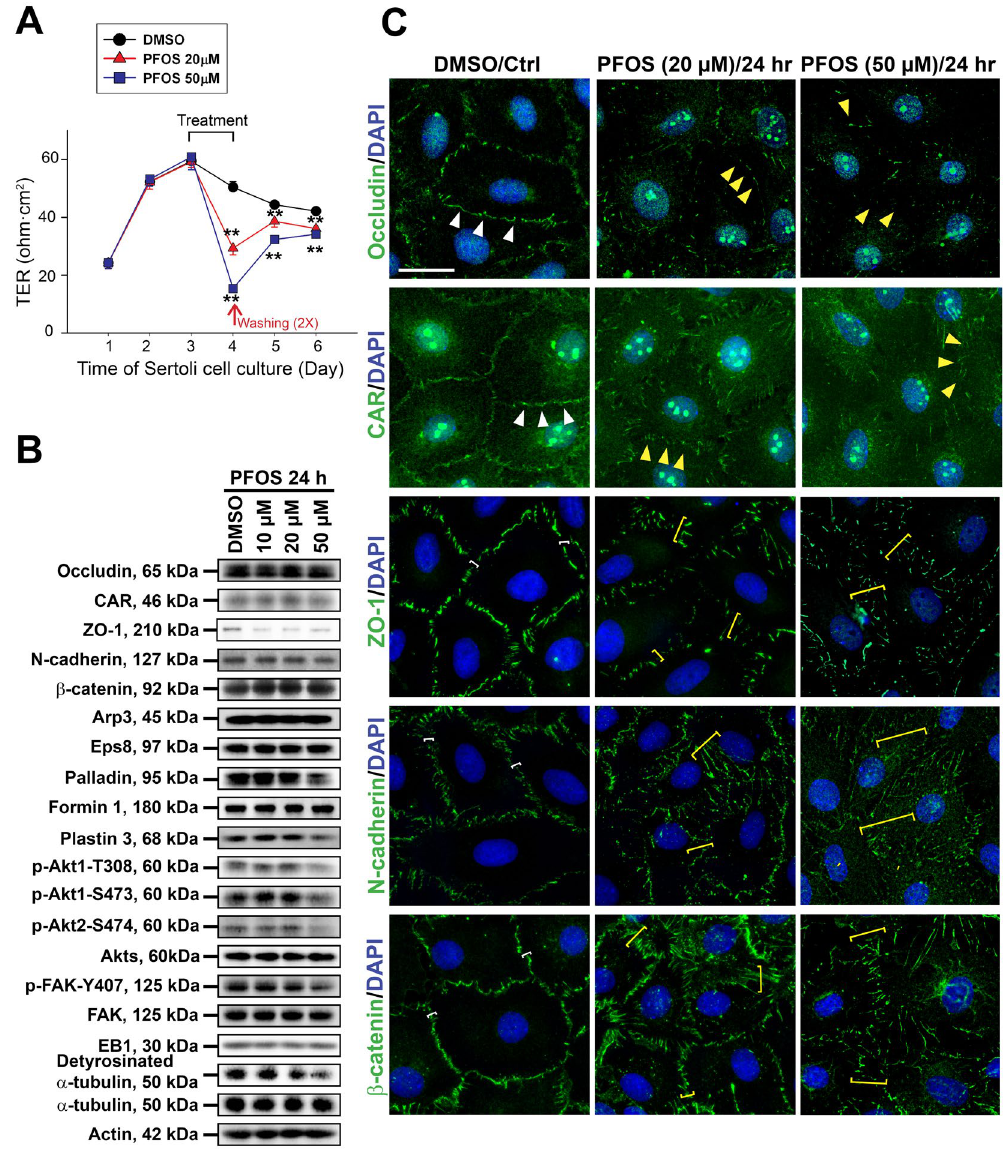
Figure 1. PFOS perturbs Sertoli cell BTB function through changes in the expression and/or localization of proteins at the immunological barrier. Sertoli cells cultured on Matrigel-coated bicameral units, dishes or coverslips were treated on day 3 with 10, 20 or 50 μ M PFOS for 24 hr. Thereafter, cells were washed twice with PBS to remove residual PFOS and terminated for immunoblotting (IB) or IF on day 4. ( A ) Typical results of a TER experiment that monitored the effects of PFOS, at 20 µ M and 50 µ M vs . vehicle control (DMSO) on the Sertoli cell TJ-permeability barrier. Each data point is a mean ± SD of triplicate units from an experiment, which was repeated 3 times and yielded similar results. ** P < 0.01 by Student’s t -test compared between PFOS- treated and control cells. ( B ) Immunoblot analysis to assess the effects of PFOS on the expression of TJ proteins: occludin, CAR and ZO-1; basal ES proteins: N-cadherin and β -catenin; actin regulatory proteins: Arp3, Eps8, palladin, formin 1 and plastin 3; signaling molecules: activated Akts: p-Akt1-T308, p-Akt1-S473, pAkt2-S474 vs . Akts (including Akt1, 2 and 3), and activated FAK: p-FAK-Tyr407 vs . FAK; MT regulatory proteins: EB1 and detyrosinated α -tubulin. Actin and α -tubulin served as protein loading controls. PFOS was found to down- regulate p-Akt1-T308, p-Akt1-S473, p-Akt2-S474 and p-FAK-Tyr407. Composite data of immunoblottings are shown in Figure S1A; and uncropped blots are shown in Figure S4. ( C ) Immunofluorescence analysis to assess the effects of PFOS at 20 µ M and 50 µ M vs . control on the distribution of TJ proteins: occludin, CAR and ZO-1; basal ES proteins: N-cadherin and β -catenin. PFOS caused internalization of TJ and basal ES proteins in Sertoli cells in which these proteins no longer tightly localized at the Sertoli cell-cell interface. Occludin and CAR at the cell-cell interface (annotated by white arrowheads) were diminished following PFOS treatment (yellow arrowheads). For ZO-1, N-cadherin and ß-catenin, these proteins were localized tightly at the cell-cell interface (white brackets) but were considerably internalized, diffusing away from the cell cortical zone (yellow brackets). Sertoli cell nuclei were visualized by DAPI. Composite analyzed data are shown in Figure S1B. Scale bar, 30 μ